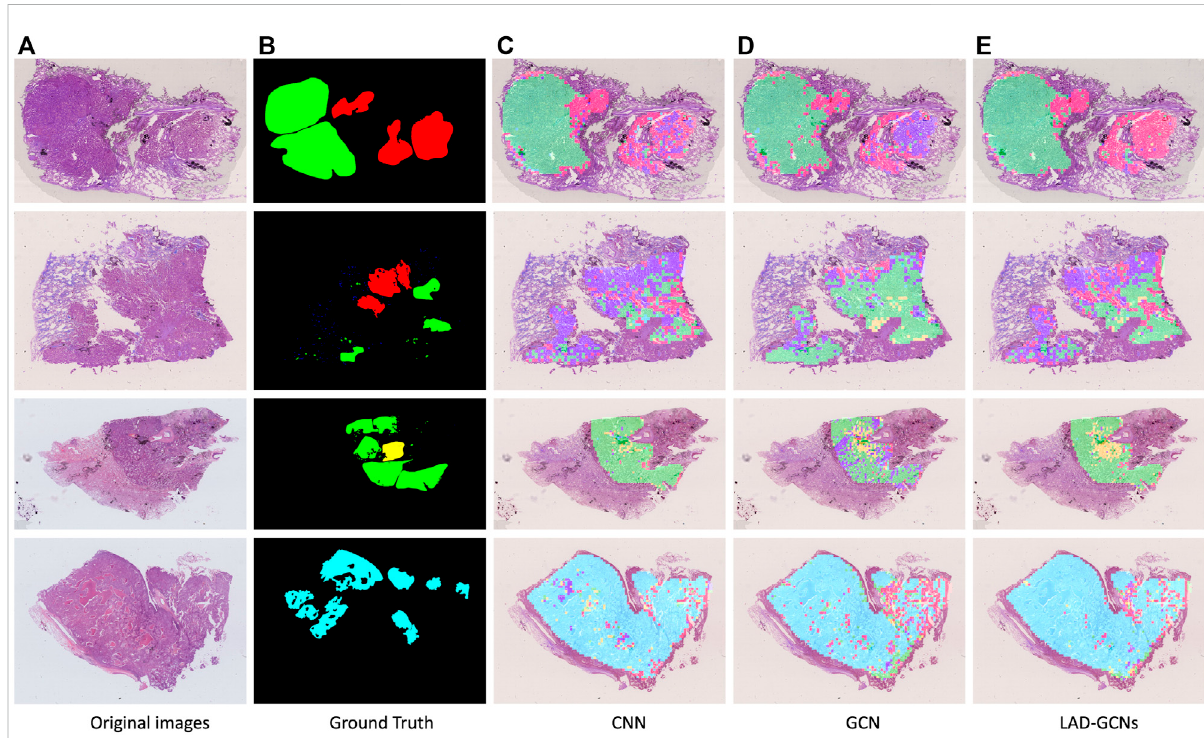
FIGURE 5 Typical histopathological image analysis results obtained with three networks. Red, green, yellow, blue, and cyan masks represent lepidic, acinar, papillary, micropapillary, and solid growth patterns, respectively. (A) Example of histopathological images. (B) Ground truth by pathologists. (C,D,E) Typicalhistopathologicalimageanalysisresultsobtainedwiththreenetworks: (C) CNN, (D) GCNand (E) LAD-GCNs.